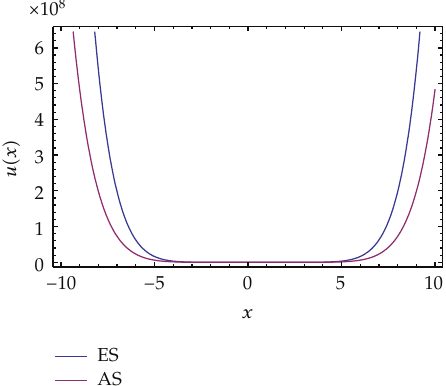
Figure 9: The compared results of the analytical and numerical solutions of Example 4.3 for t (cid:3) 1 . 5.